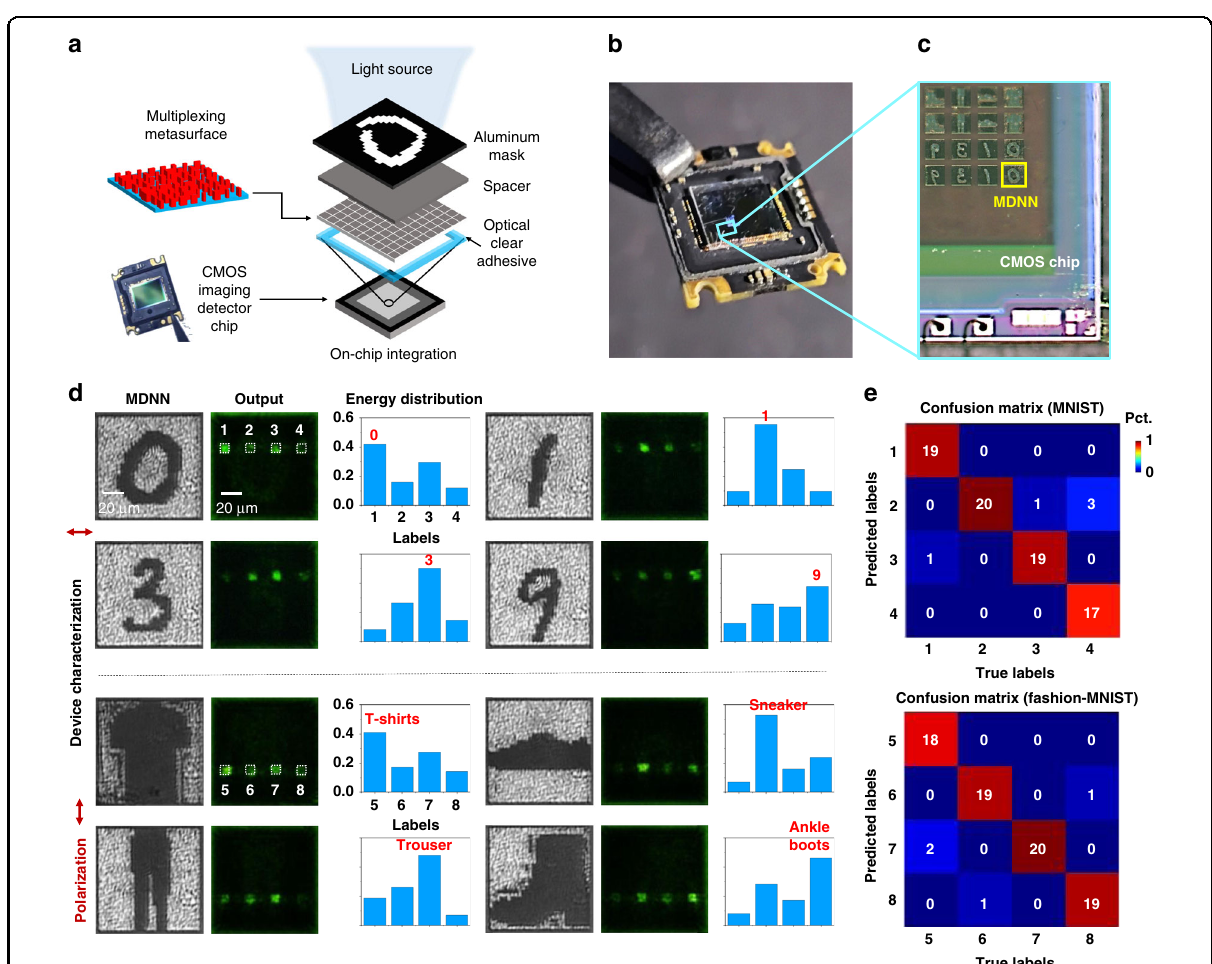
Fig. 5 Experimental demonstration of the on-chip MDNN. a Exploded schematic diagram of the MDNN integrated with a CMOS chip. b Physical photograph of the on-chip MDNN. c Optical micrograph of the fabricated MDNN built on a CMOS imaging sensor. d The fabricated MDNN (1st and 4th columns), the output fi eld intensity detected by the CMOS imaging sensor for these four-category classi fi cation MDNN in x - or y -polarization (2nd and 5th columns), and experimentally detected energy distribution (3rd and 6th columns). e Experimental confusion matrices for MNIST and Fashion- MNIST classi fi cation, respectively, with 80 images randomly selected from the correct set of simulations, for counting in the four classes (i.e., 20 per class). Pct.